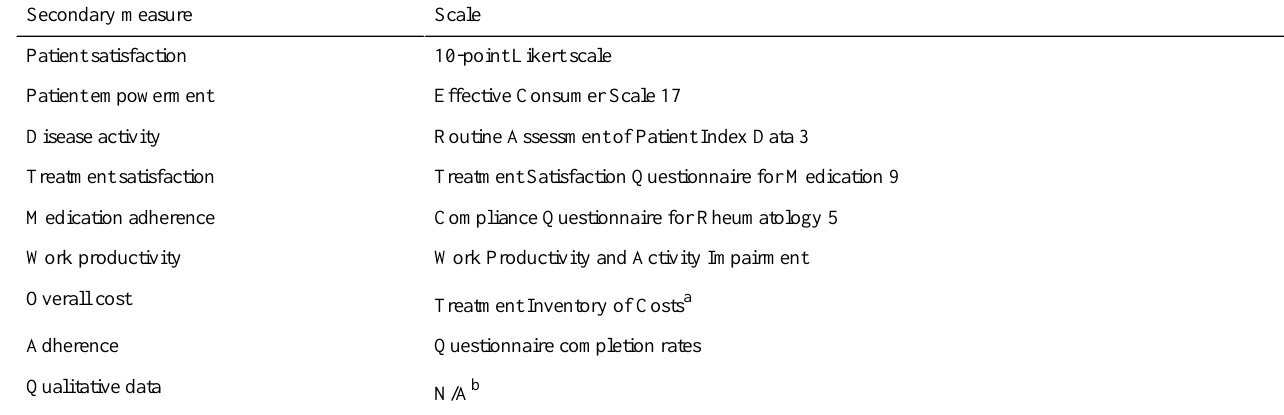
Table 2. Secondary